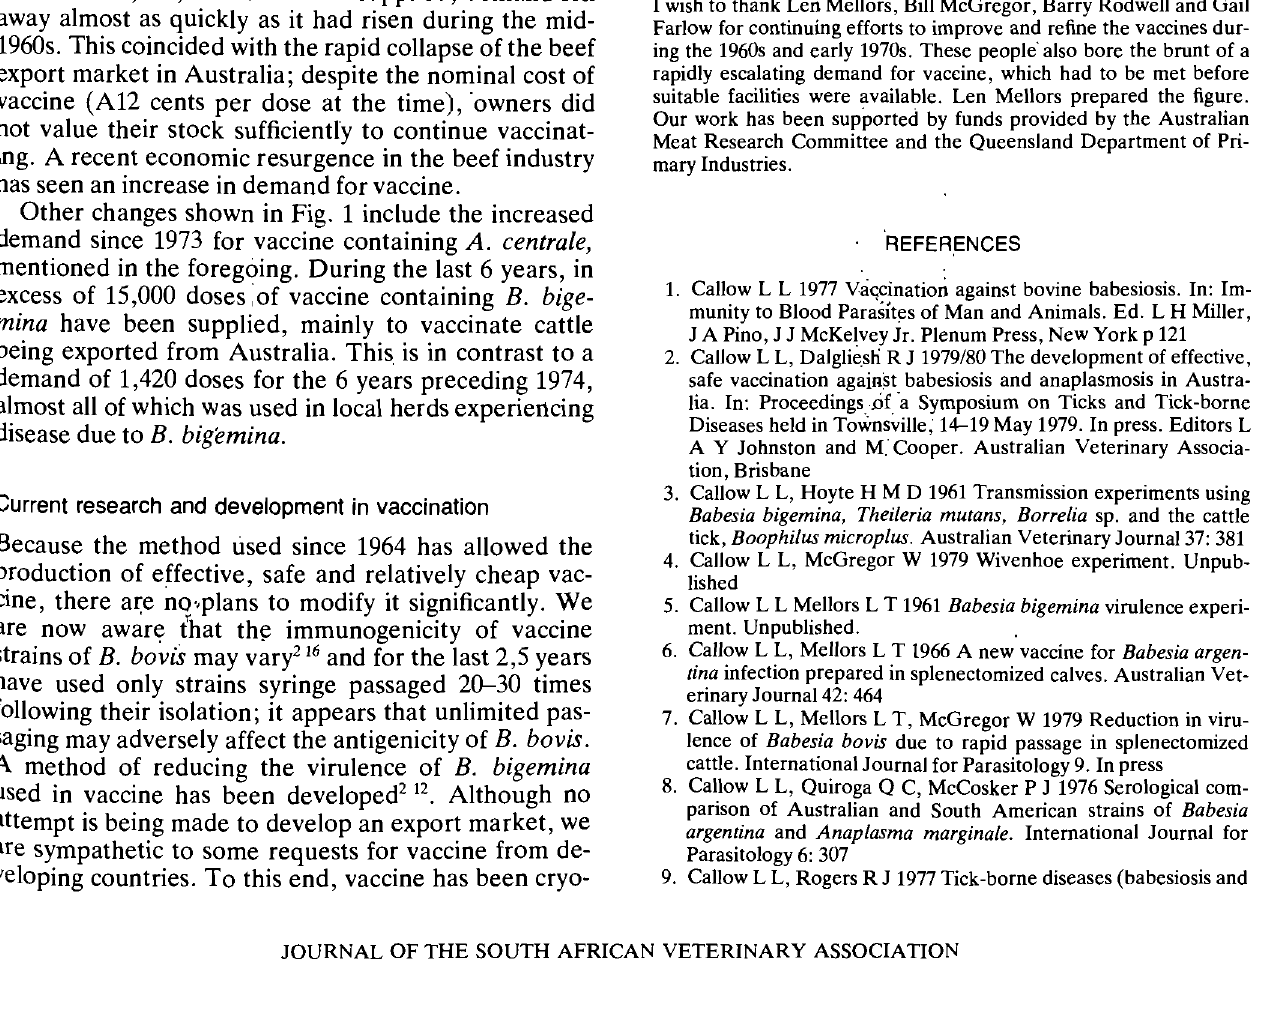
Demand for vaccine,